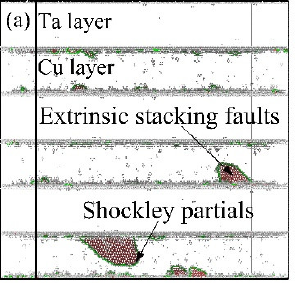
Figure 3. Snapshots of the defect evolution for the sample with h = 5.6 nm: ( a ) ε = 0.059 (point A 1 ), ( b ) ε = 0.061 (point B 1 ), ( c ) ε = 0.073 (point C 1 ), ( d ) ε = 0.108 (point D 1 ).